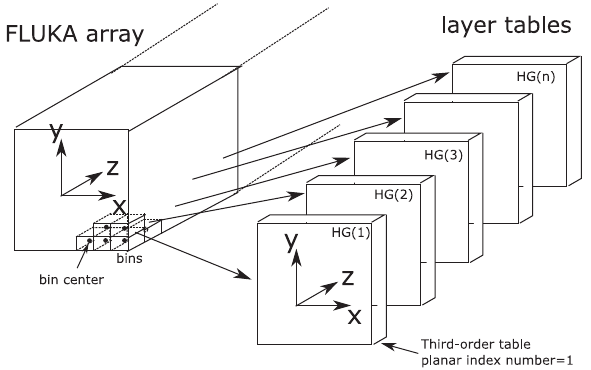
FIG. 1. Schematic segmentation of a data array with energy density values obtained through FLUKA into several table arrays, each with a distinct heat generation profile (HG). The energy density location is applied in the center of the